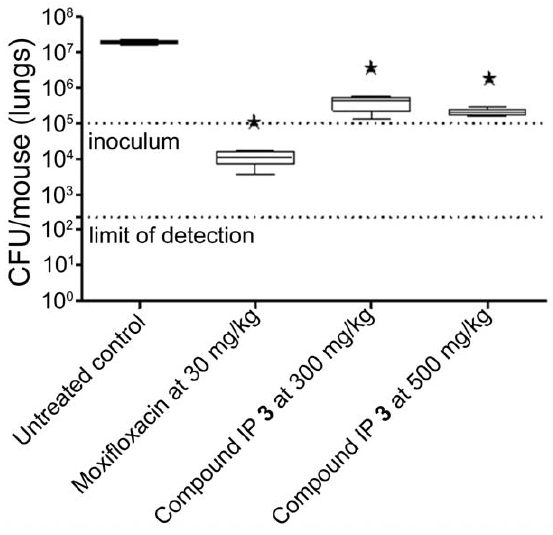
Figure 3. Therapeutic efficacy of anti-tubercular IP 3 against M. tuberculosis H37Rv invivo . B6 mice were infected by intra-tracheal instillation with 10 5 cfu M. tuberculosis H37Rv per mouse. The mice were treated with the anti-tubercular orally once a day from day 1 to day 8. Efficacy results are expressed as log cfu reduction in the lungs of infected mice and are the mean 6 SD of five mice. The shaded line indicates the levels of administered mycobacterial inoculum.